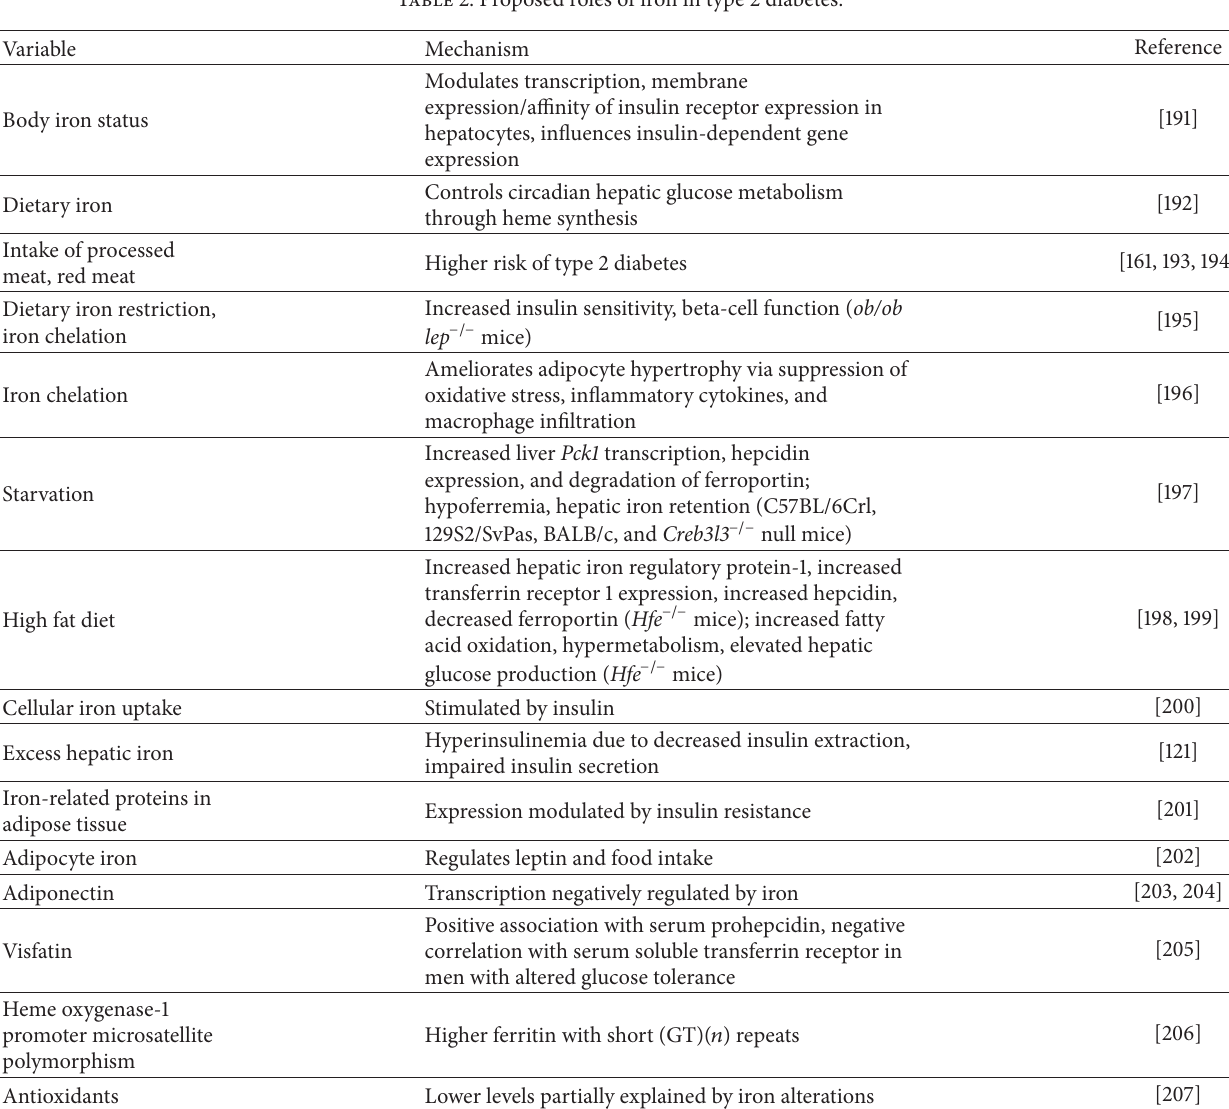
Table 2: Proposed roles of iron in type 2